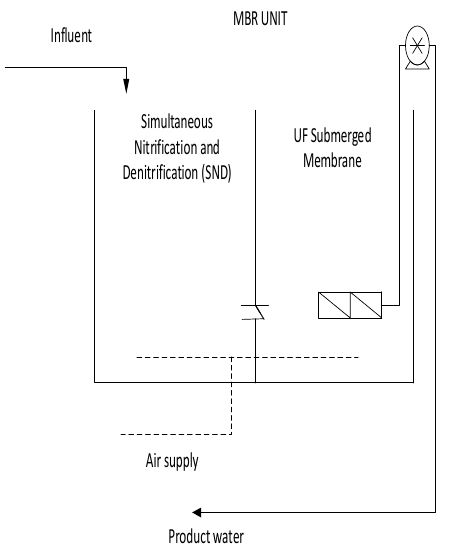
Figure 4. Schematic representation of the MBR unit used.